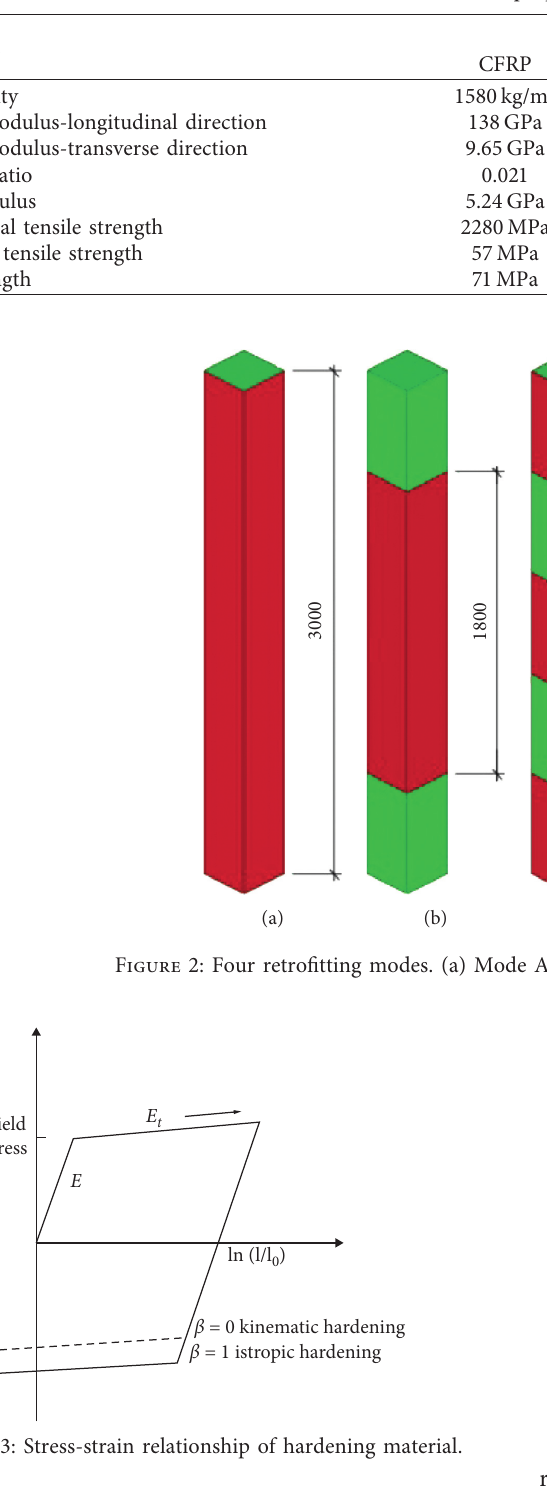
Table 2: Material properties for